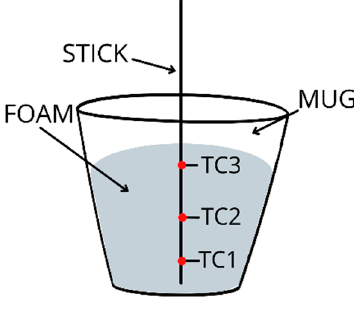
Figure 10. Scheme of measuring temperature distribution during foam growth.